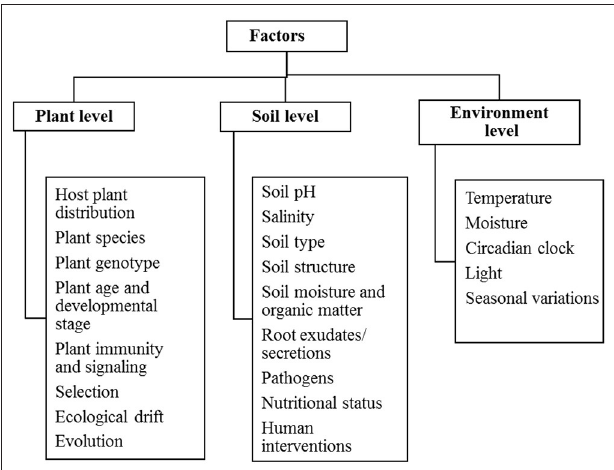
FIGURE 3 | Factors affecting plant-microbe